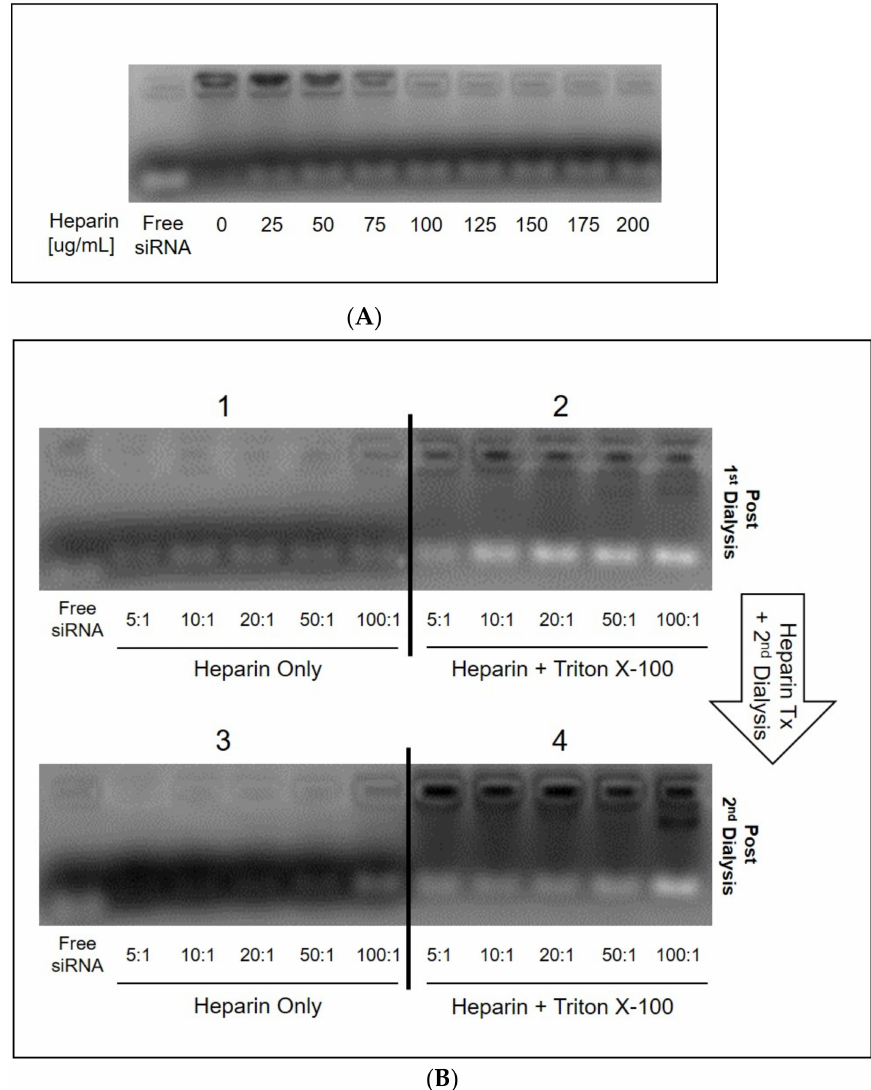
Figure 5. ( A ) Assay development indicated treatment with 100 ug/mL heparin was the minimum concentration required for effective removal of all outer-associated siRNA. ( B ) Heparin displacement assays indicated siRNA complexation to R8-PLP surface (panel 1), total EE% (panel 2), and siRNA entrapment within the R8-PLP core (panels 3 and 4), in a lipid:siRNA dependent